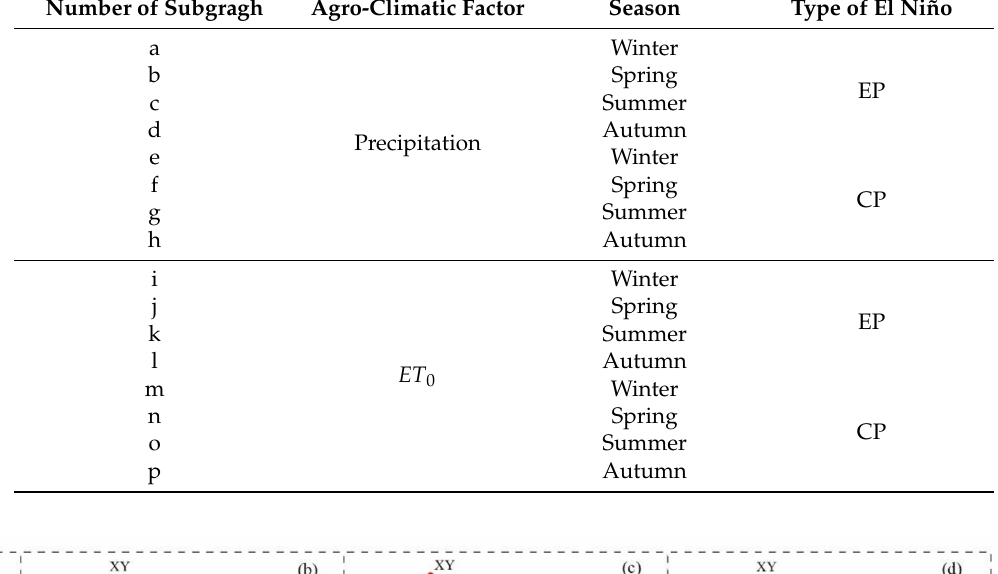
Table 4. The description of Figure 7.